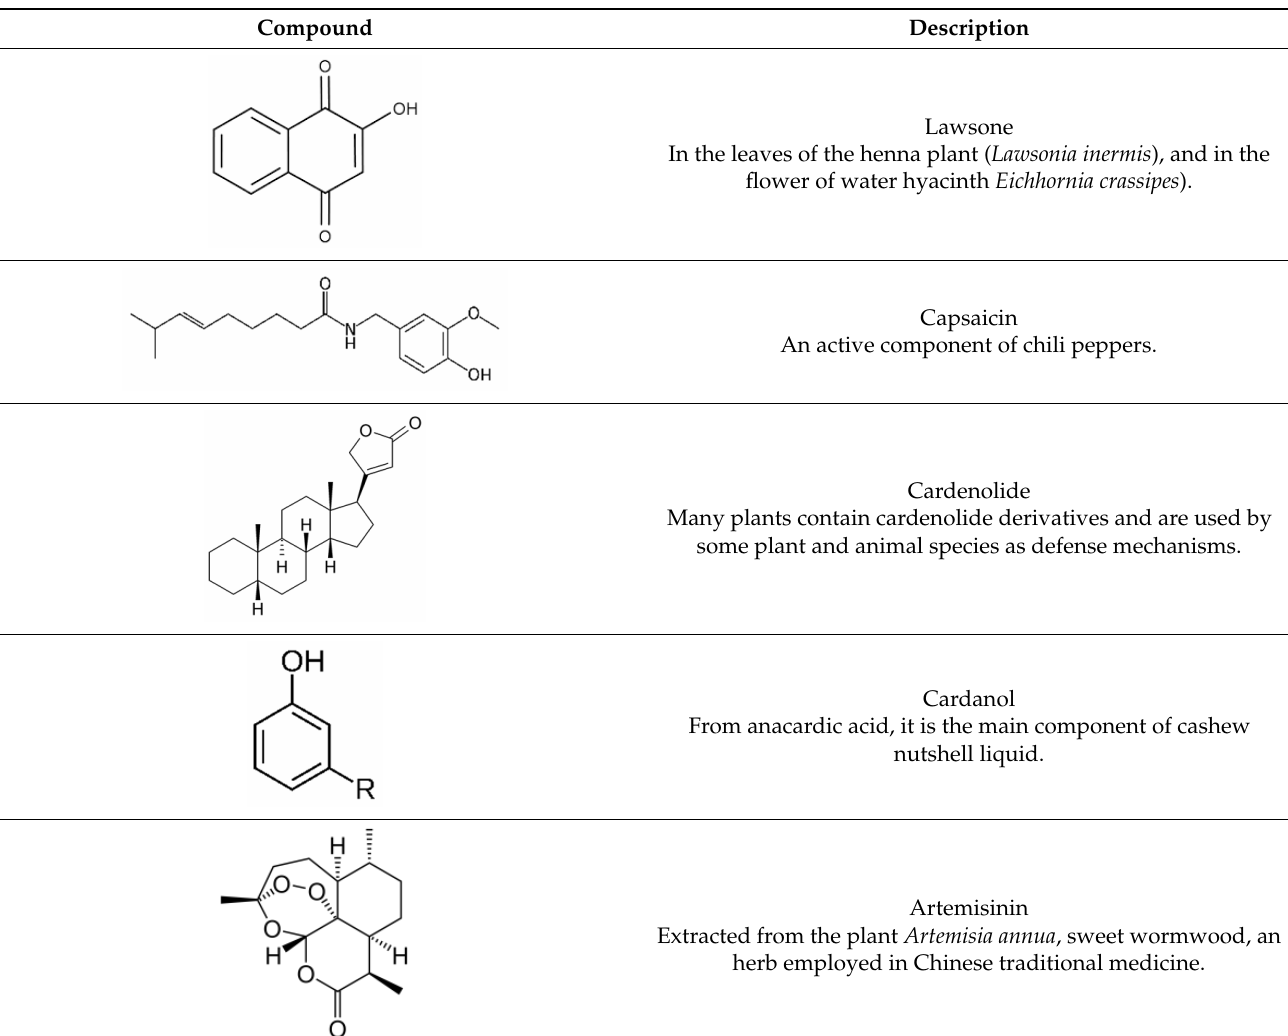
Table 3. Some compounds in plant extracts used as antimicrobial additives in epoxy resins.